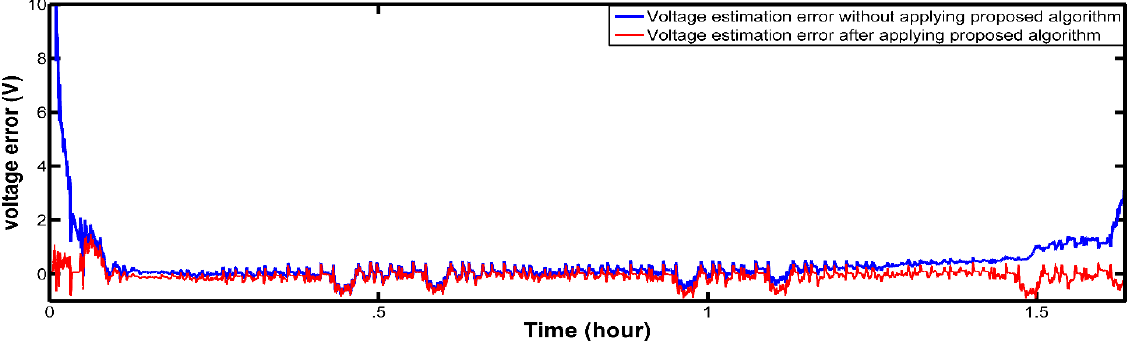
Figure 12. ( a ) Normalized FTP-75 current profile; ( b ) Observed SOC and estimated SOC for the pack by proposed method; ( c ) SOC estimation error for different initial values.